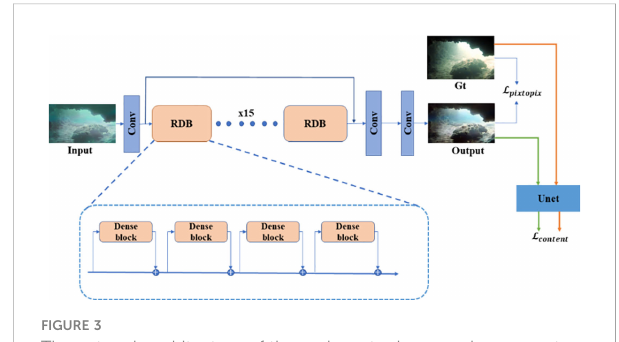
FIGURE 3 The network architecture of the underwater image enhancement model